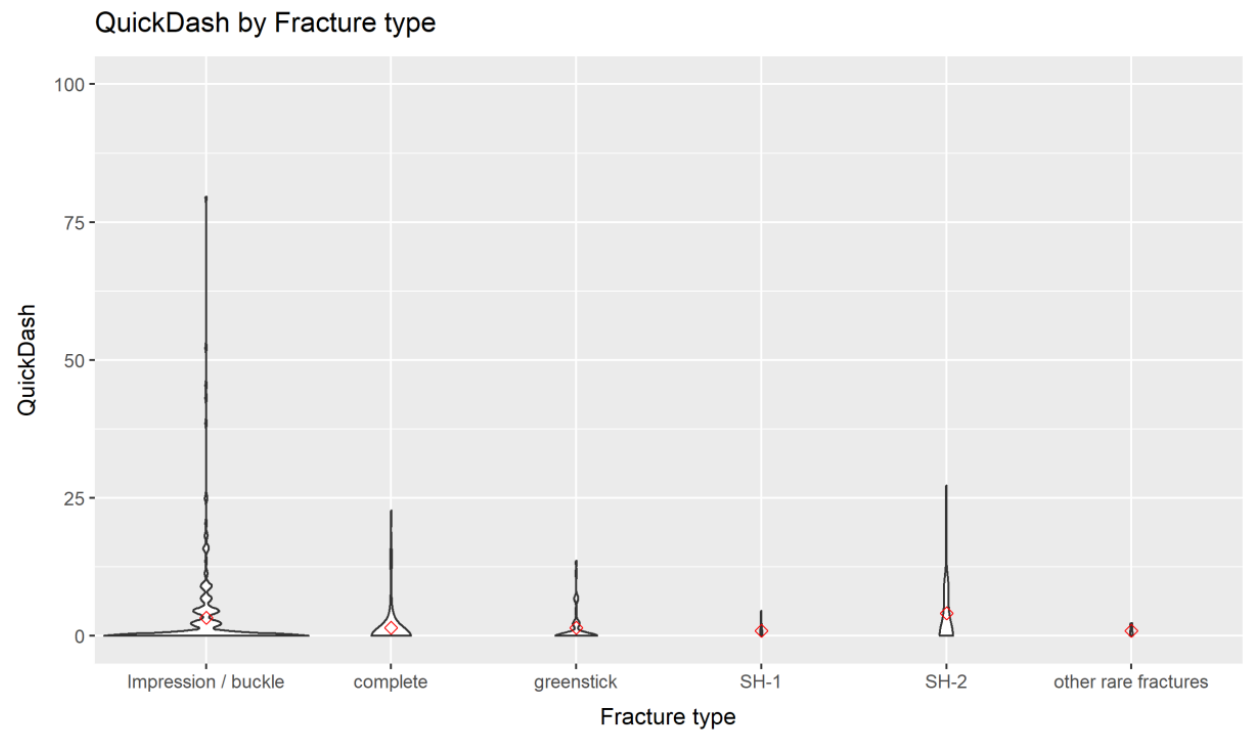
Figure 2. The primary outcome Quick-DASH at follow-up by fracture type of the radius. Since there were considerable ceiling effects, we used violin plots for the graphical presentation. Please see the methods section for a description of the violin plots.